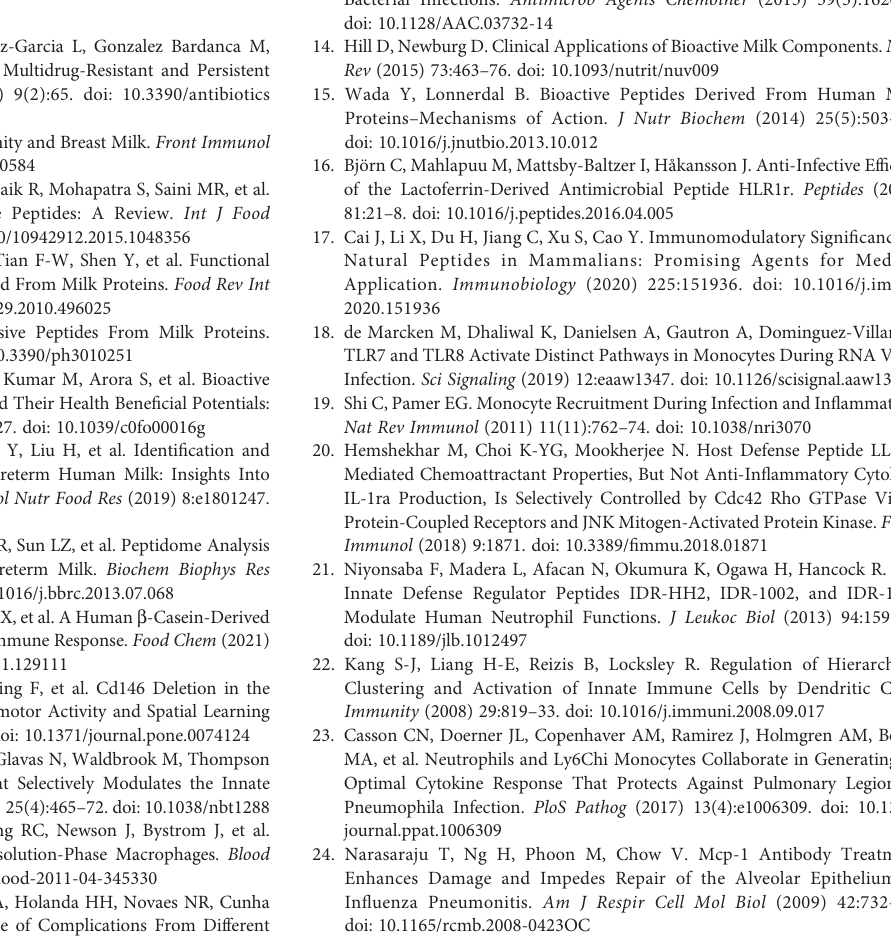
cells can be roughly differentiated into 3 main populations on FSC/SSC (P1- Lymphocytes, P2- Monocytes and P3- Granulocytes). The percentage of TAMRA- BCCY-1 positive cells in each population was analyzed. Supplementary Figure 2 | The FACS gating strategy used for the analysis of the monocyte/macrophage populations in the peritoneal lavage fl uid. The distinct subsets of monocytes/macrophages could be distinguished by expression of the markers Ly6C and F4/80. Monocytes: Ly6C + F4/80 - , monocytes/macrophages: Ly6C + F4/80 + , macrophages: Ly6C - F4/80 + . Supplementary Figure 3 | Flow charts showing the timing of experimental treatments and infection. (A) The systemic infection model, (B) The clodronate model, (C) The neutropenic model, Cy: Cyclophosphamide, (D) the lymphopenia model. Supplementary Figure 4 | The percentage of Ly6C + monocytes after BCCY-1 treatment. (A) In the peripheral blood. Quanti fi cation of Ly6C + monocyte percentage is shown as a bar graph in the right panel. ns p >0.05. (B) In the peritoneal lavage fl uid. Quanti fi cation of Ly6C + monocyte percentage is shown as a bargraphinthe rightpanel. ** p <0.01. Thescrambled versionofBCCY-1servedas the control. Supplementary Figure 5 | The MCP-1 level in the peritoneal lavage fl uid of E. coli -infectedmouse after Saline orBCCY-1 treatment. Peritoneallavage fl uids ofthe indicated treatment after 24 h of infection were analyzed for MCP-1 production by ELISA. ** p